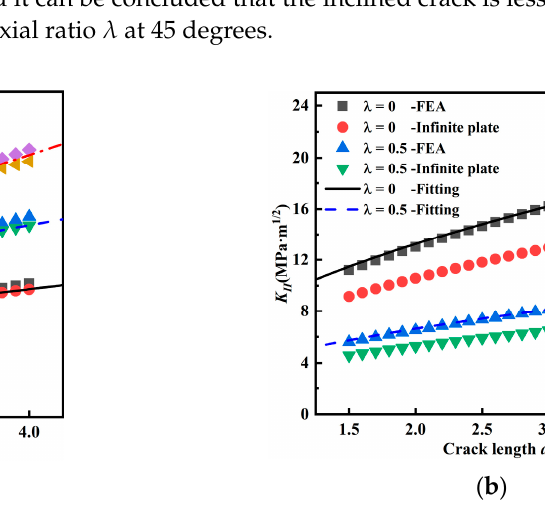
Figure 6. Stress intensity factor K I and K II ( β = 45 ◦ ). ( a ) Relationship between K I and a and ( b ) rela- tionship between K II and a